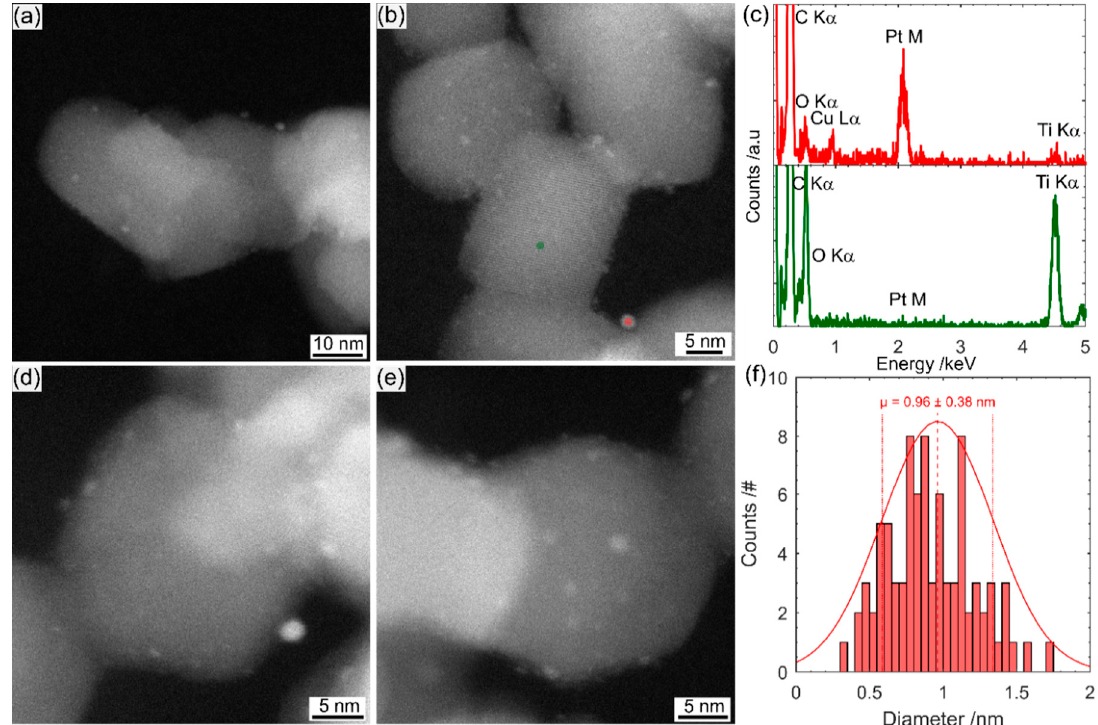
Figure 2. Transmission electron microscope (TEM) images ( a , b , d , e ), energy-dispersive X-ray spectroscopy (EDS) plots ( c ) and particle size histogram ( f ) for P25-Pt-np samples produced via Pt photodeposition. The EDS plots ( c ) are from points highlighted in ( b ) with green and red circle corresponding to the green (TiO 2 only) and red (Pt np on TiO 2 ) EDS spectra. Pt np diameter distribution ( f ) with normal distribution analysis obtained from >5 images and 89 measured